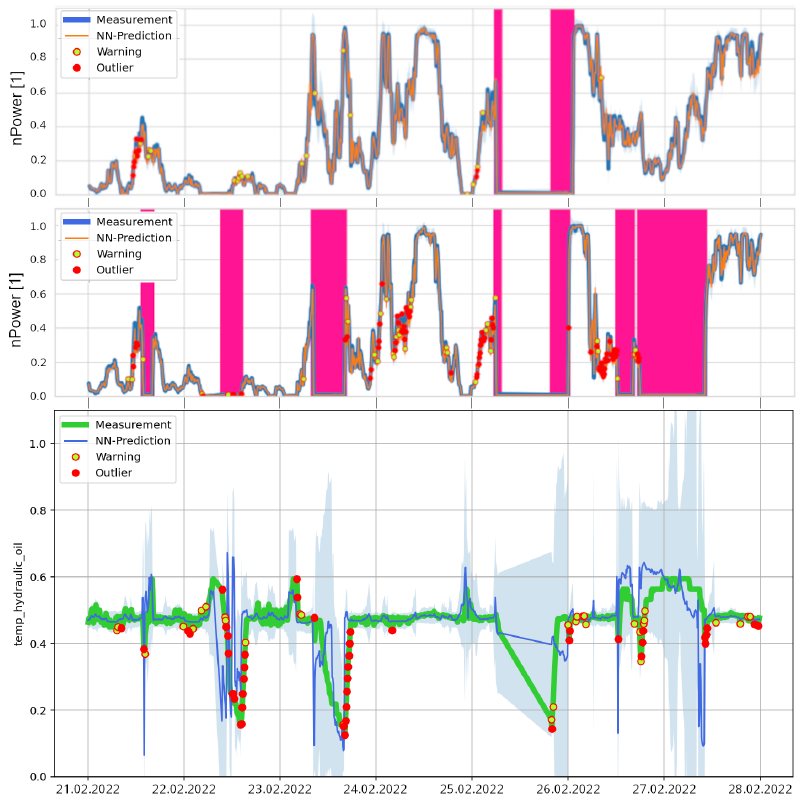
Figure 8. An example week for the WTG 120 (top) and 109 (middle) with several gearbox error codes. As can be seen for WTG 109, in some cases there is a accumulation of anomalies quite some time before the gearbox failure (21, 25, and 26 February 2022). On the other hand there is no anomaly accumulation before the 22 and especially the 23 February 2022. Furthermore, there is an anomaly accumulation at the 24 February 2022 with no following gearbox failure. Temperature of the hydraulic oil (bottom) is however spiking before the 22. The same week as for the WTG 109 is shown for the WTG 120. There is no significant anomaly accumulation on the 25 February 2022 and there is an accumulation on the 21 February 2022, where no gearbox failure is detected. nPower refers to normalised power, which is the power divided by the maximum observed power in the data